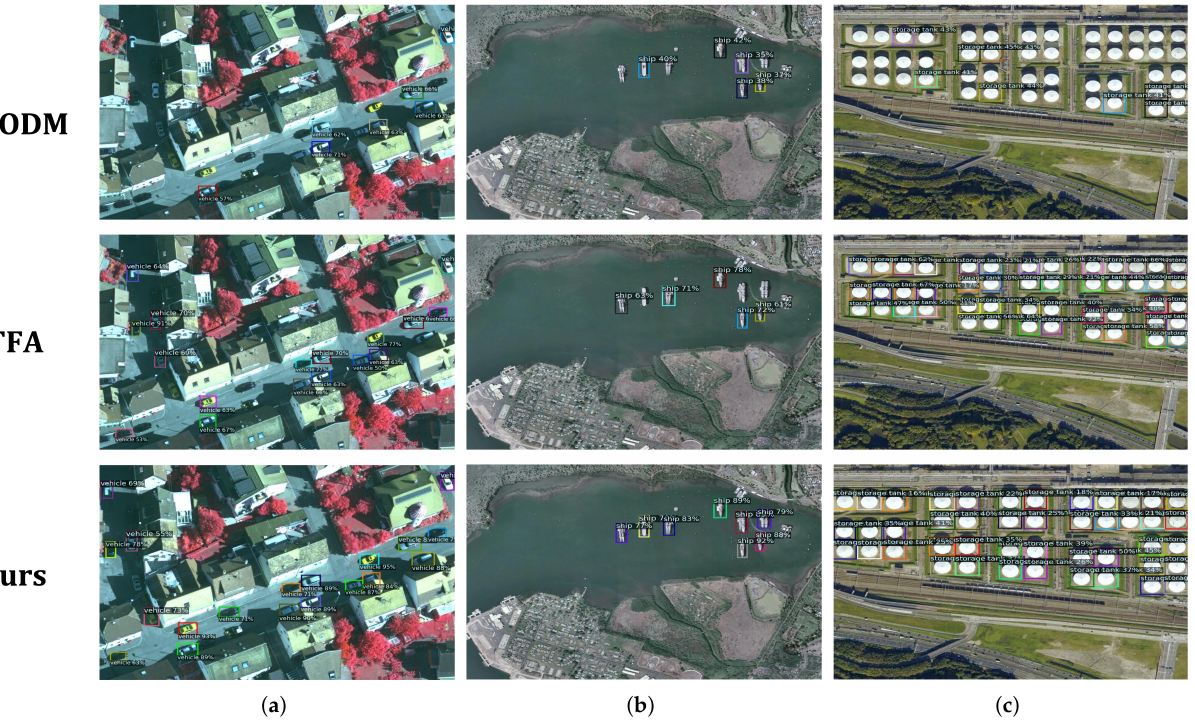
Figure 10. Qualitative inference results of base categories on the NWPU VHR-10 dataset. ( a ) vehicle, ( b ) ship, ( c ) storage